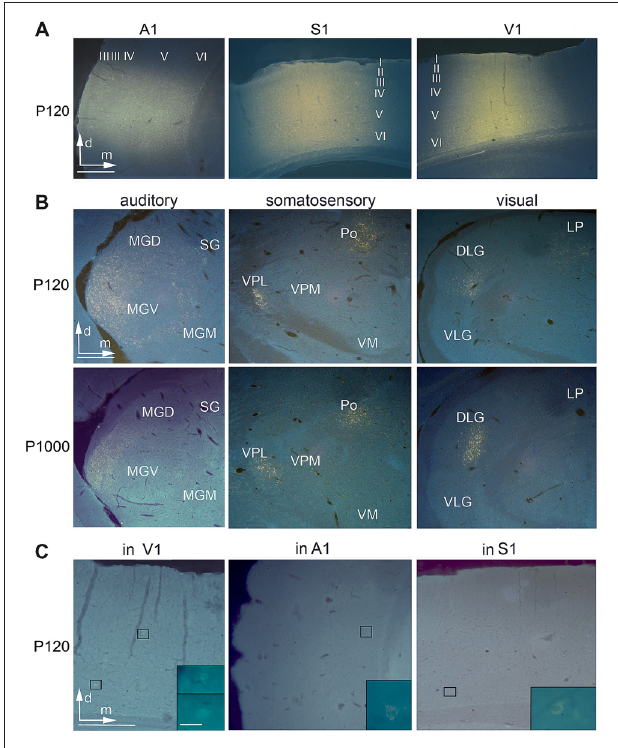
FIGURE 2 | Anatomical tracer injections into the primary sensory cortices reveal multisensory connections at all ages. (A) Frontal sections showing injection sites of Fluorogold (FG) into A1, S1, and V1 at P120. (B) Retrogradely labeled cell bodies in auditory (MGD/M/V, dorsal/medial/ventral part of the medial geniculate body (MGB); SG, suprageniculate thalamic nucleus), somatosensory (Po, posterior; VM, ventromedial; VPL/M, ventral posterolateral/posteromedial thalamic nucleus), and visual (D/VLG, dorsal/ventral lateral geniculate nucleus; LP, lateral posterior thalamic nucleus) thalamic nuclei following tracer injections into A1, S1, and V1 at P120 and P1000. (C) Retrogradely labeled cell bodies in V1 after injection into A1, in A1 after injection into S1, and in S1 after injection into V1; always at P120. Scale bars 500 µ m and 20 µ m (insets).